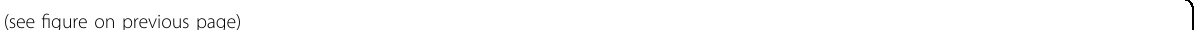
Fig. 2 Pharmacological inhibition of GSK3 β by TDZD-8 or LiCl attenuates the TGF- β 1 induced TEC pro fi brogenic plasticity in a dose- dependent fashion. A The immortalized murine renal proximal tubular epithelial cells (TKPT) were treated with or without TGF- β 1 (0.5, 1, 2, 4 ng/ml) for 24 h. Cell lysates were prepared for immunoblot analysis for GSK3 β and GAPDH. Representative immunoblots were shown. B TKPT were treated with or without TGF- β 1 (2 ng/ml) for 12 h, 24 h, or 48 h. Cell lysates were prepared for immunoblot analysis for GSK3 β and GAPDH. Representative immunoblots were shown. C TKPT were treated with TGF- β 1 (2 ng/ml) for 24 h following pretreatment with different dose of TDZD-8 (0, 2, 5, 10 μ mol/L) or ( D ) LiCl (0, 2, 5, 10 mmol/L) for 30 min. Cell lysates were prepared for immunoblot analysis for E-cadherin, vimentin, fi bronectin (FN), PAI-1, CTGF, pH3, and GAPDH. Representative immunoblots were shown. E , F Densitometric analyses of the expression of E-cadherin, vimentin, FN, PAI-1, CTGF, and pH3, as normalized to the expression of GAPDH based on immunoblot analysis. * P < 0.05 versus TGF- β 1 treatment group ( n = 3, t -test). G TKPT were treated with TGF- β 1 in the presence or absence of LiCl (10 mmol/L) for 24 h and then fi xed for immuno fl uorescent staining of E-cadherin, ZO-1, vimentin, pH3, and FN with nuclear counterstaining with DAPI. Representative fl uorescent micrographs were shown. Scale bar = 100 μ m. CTGF, connective tissue growth factor; DAPI, 4 ′ ,6-diamidino-2-phenylindole; FN, fi bronectin; GAPDH, glyceraldehyde-3-phosphate dehydrogenase; PAI-1, plasminogen activator inhibition-1; pH3, phosphorylated histone H3; ZO-1, zonula